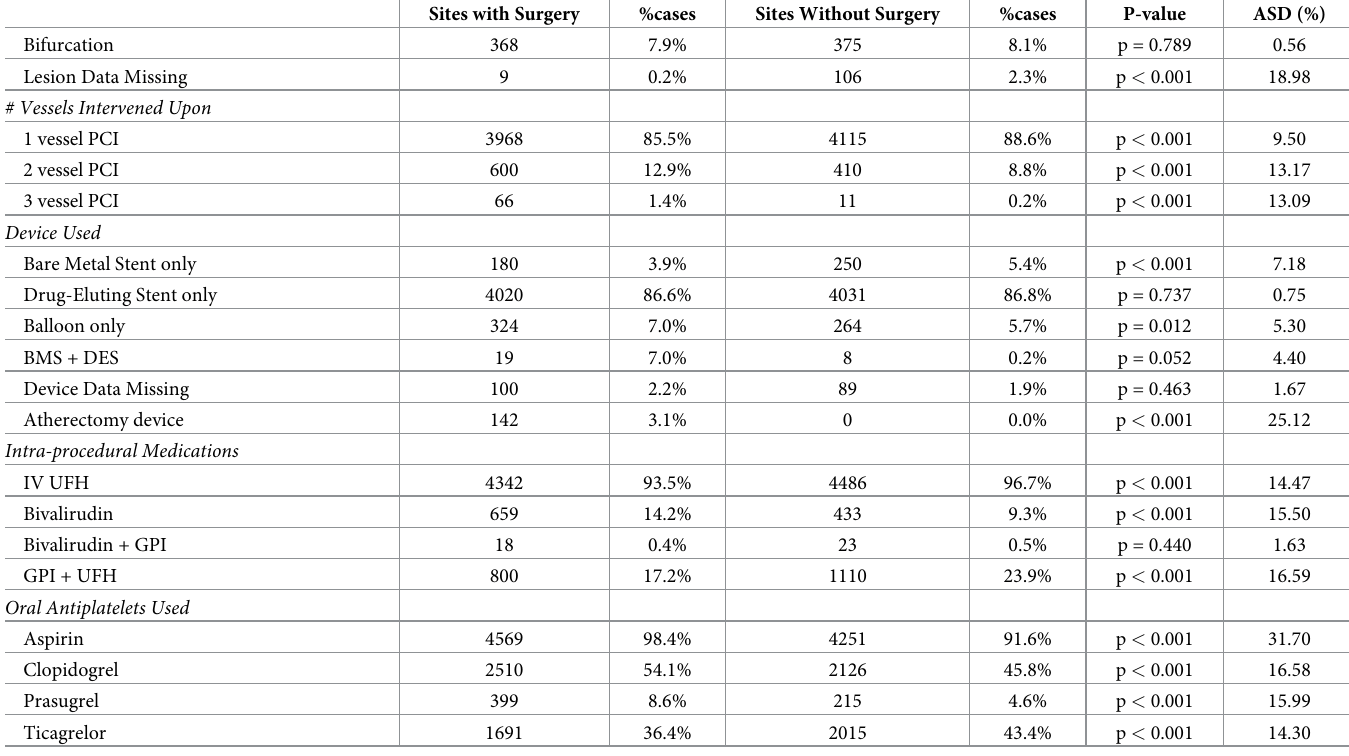
cardiovascular events (2.6% vs. 2.8%; p = 0.443), secondary composite outcome of MACE (1.2% vs. 0.8%; p = 0.060), or all-cause in-hospital mortality (0.6% vs. 0.5%; p = 0.465) at sites with and without cSoS. Furthermore, there were also no statistically significant differences in secondary outcomes of major bleeding, RBC/whole blood transfusion, other vascular compli- cations requiring transfusion, subacute stent thrombosis, target lesion revascularization, new requirement for dialysis, urgent/emergent CABG, CIN, or length of stay. Rates of CVA/stroke and heart failure were lower at non-surgical sites, but did not meet criteria for clinical signifi- cance. This was further displayed after adjustment accounting for multiple comparisons using the Bonferroni method for CVA (0.4% vs. 0.1%; p = 0.126), while heart failure still maintained statistical significance without clinical significance. (1.9% vs. 1.1%; p = 0.014). After exclusion of high-risk cases from the matched cohort, we again found no significant differences between the two groups (S4 Table). Lastly, the comparison of outcomes in matched high-risk patients, an overall low volume of cases given CON Restrictions at non-cSOS, showed no differences in major or secondary outcomes between the two sites. (S5 Table). Readmission rates, costs, and long-term mortality Of the 50,817 non-PPCI cases in the analysis cohort, 10,104 (19.9%) Medicare fee-for-service patients were matched to MVC claims-based episodes. Of the matched cases, 9,340